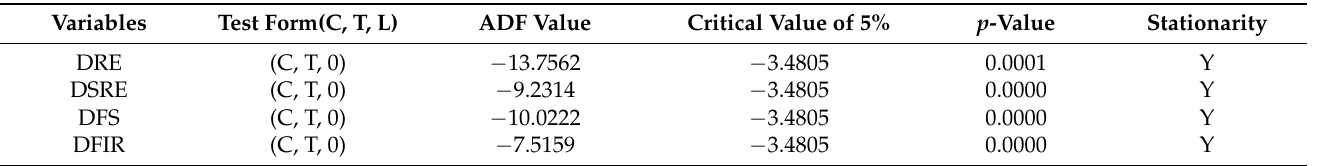
Table 6. Results of ADF test.